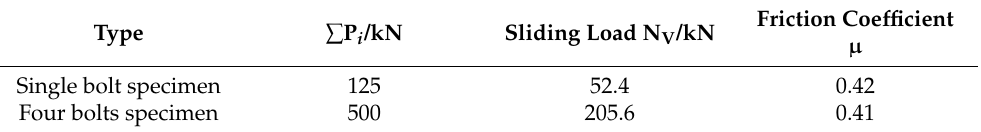
Table 3. Friction coefficient of steel sliding